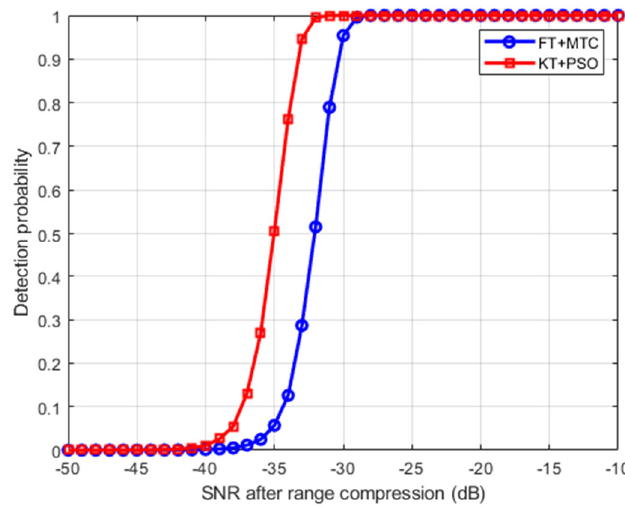
Figure 9. Detection probability of the proposed method and the existing method.